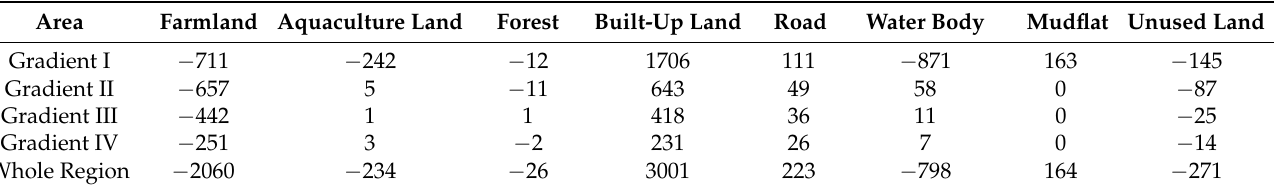
Table 13. Variations of each landscape type area from 2005 to 2020